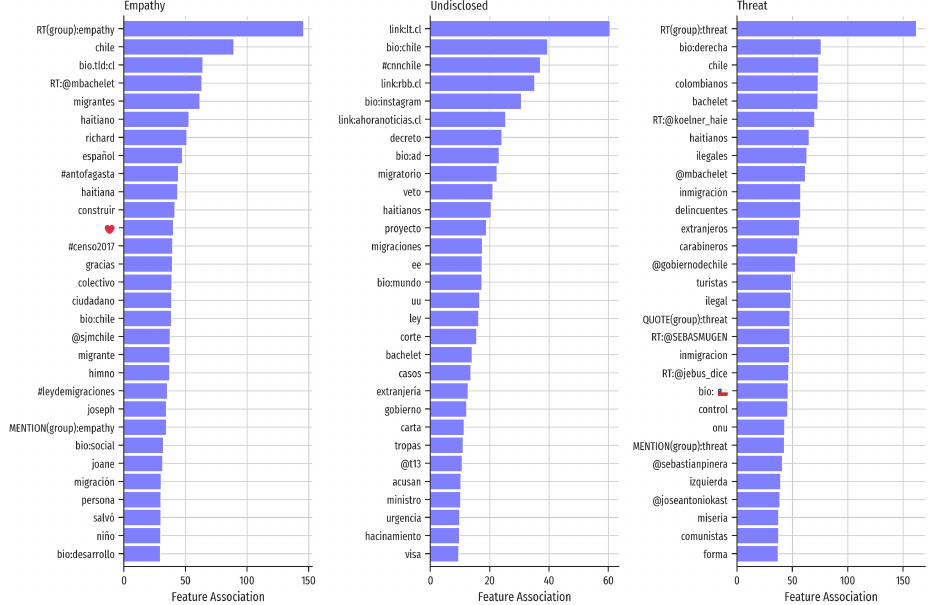
Figure 5. Top-term associations to each attitude (or lack thereof), estimated using log-odds ratio with uninformative Dirichlet